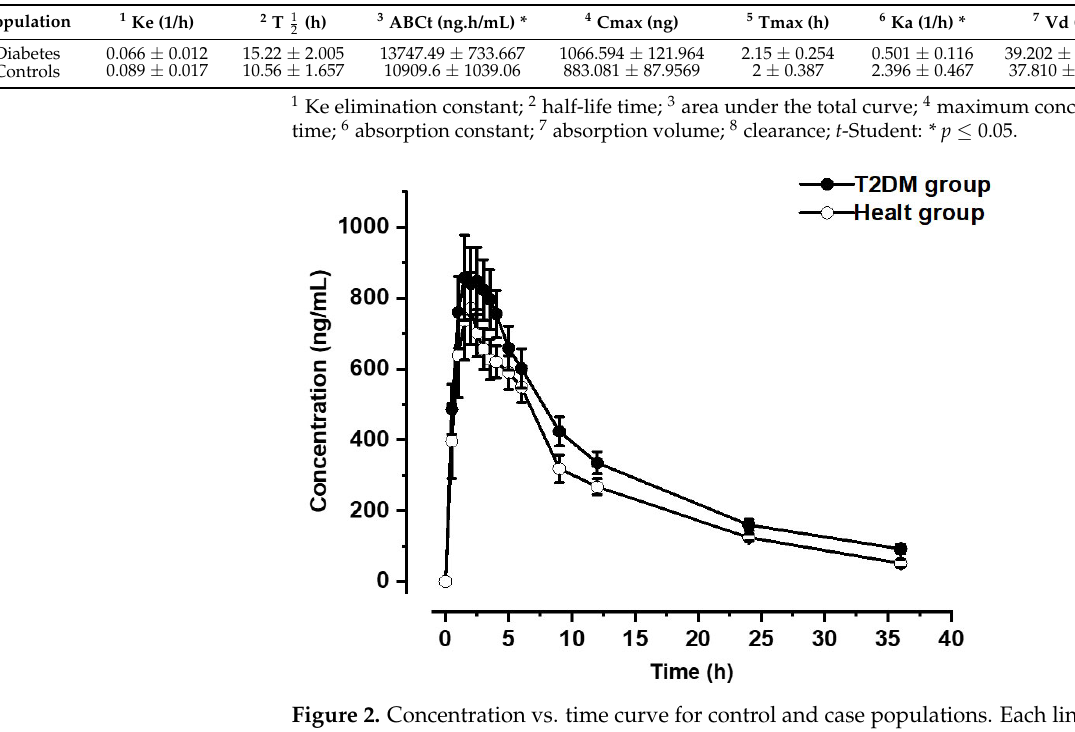
Table 3. Pharmacokinetic parameters of the studied